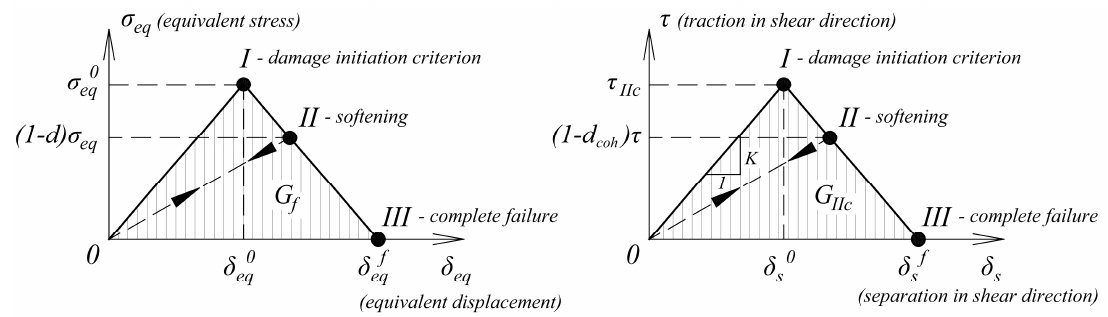
Figure 7. Graphical representation of bi-linear softening law for timber and adhesive material.